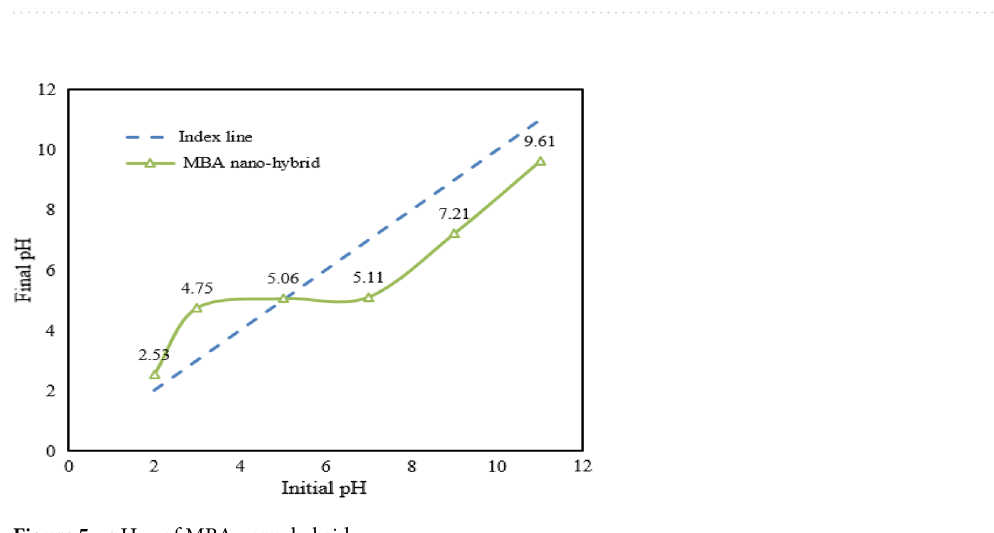
Figure 4. Effect of pH on the adsorption of Cd on MBA nano-hybrid. ([Cd] 0 = 40 mg/L, [MBA] 0 = 1.0 g/L, temperature = 25 °C, contact time = 60 min).